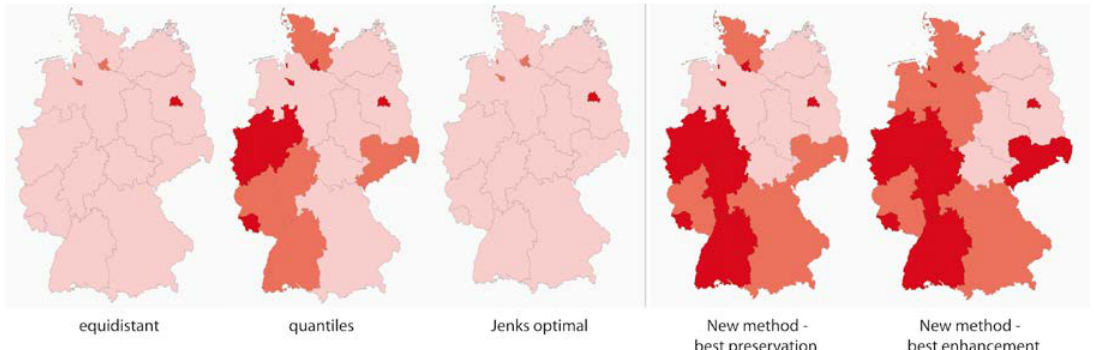
Figure 6. Comparison of choropleth maps generated with different methods for data classification following the purpose of preserving large value differences of adjacent polygons: Data set shows population density in Germany in 2012 (darker colors indicate larger values), in each map three classes are used.